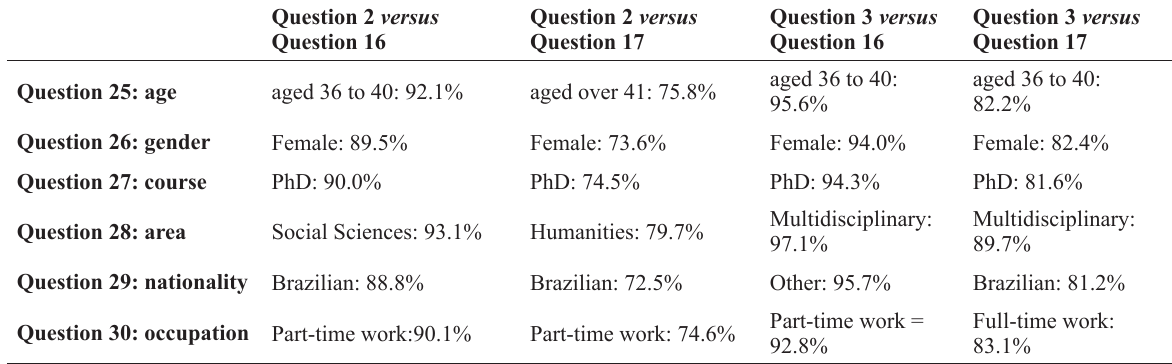
Larger percentage verified for respondents who marked “fully agree” (Question 2 and Question 3) versus “no” (Question 16 and Question 17) crossed with the responses to the questions with profile characteristics.